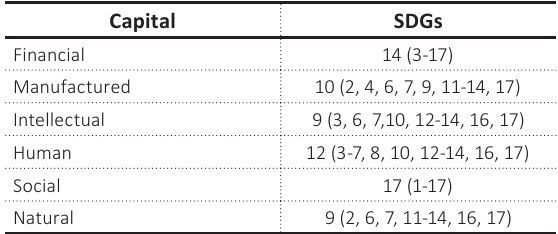
Table 1. Relevant SDGs by type of entities